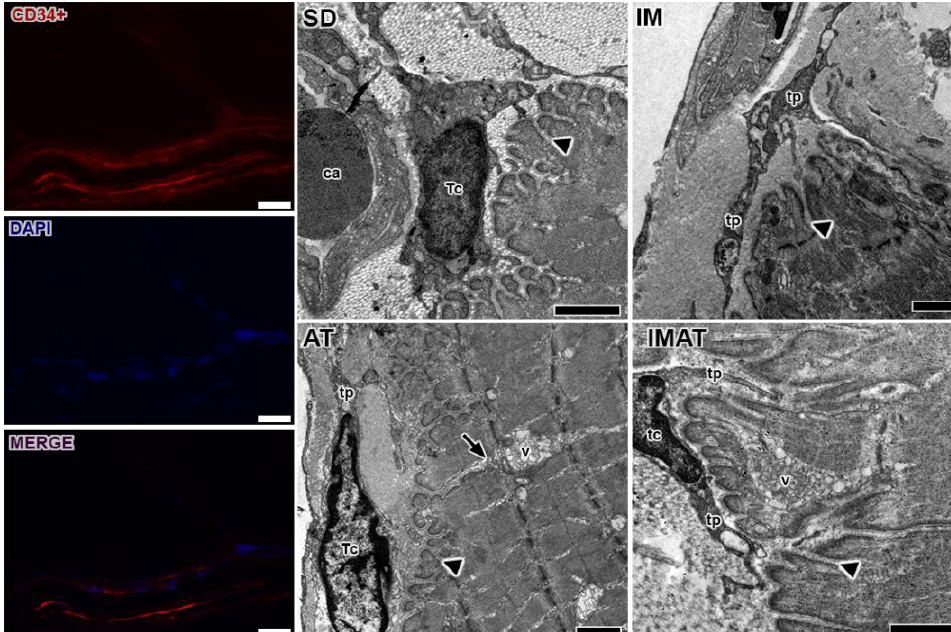
Figure 3. Telocytes analysis of MTJ region with immunostaining (CD34+), nucleus (DAPI), and the image with associated elements (MERGE). Bars: 20 µ m. Transmission electron microscopy of MTJ of sedentary (SD), immobilization (IM), aquatic training (AT), and immobilization/aquatic training (IMAT) from gastrocnemius muscle of Wistar rats. In the myotendinous region the presence of blood capillary (ca) and telocyte (tc) with their projections the telopods (tp) is observed; these elements were observed adjacent to sarcoplasmatic invaginations (arrowhead), and in the AT group a prolonger branch of sarcoplasmatic invagination (arrow) with association with a vesicle group (v) is observed. Bars: 1 µ